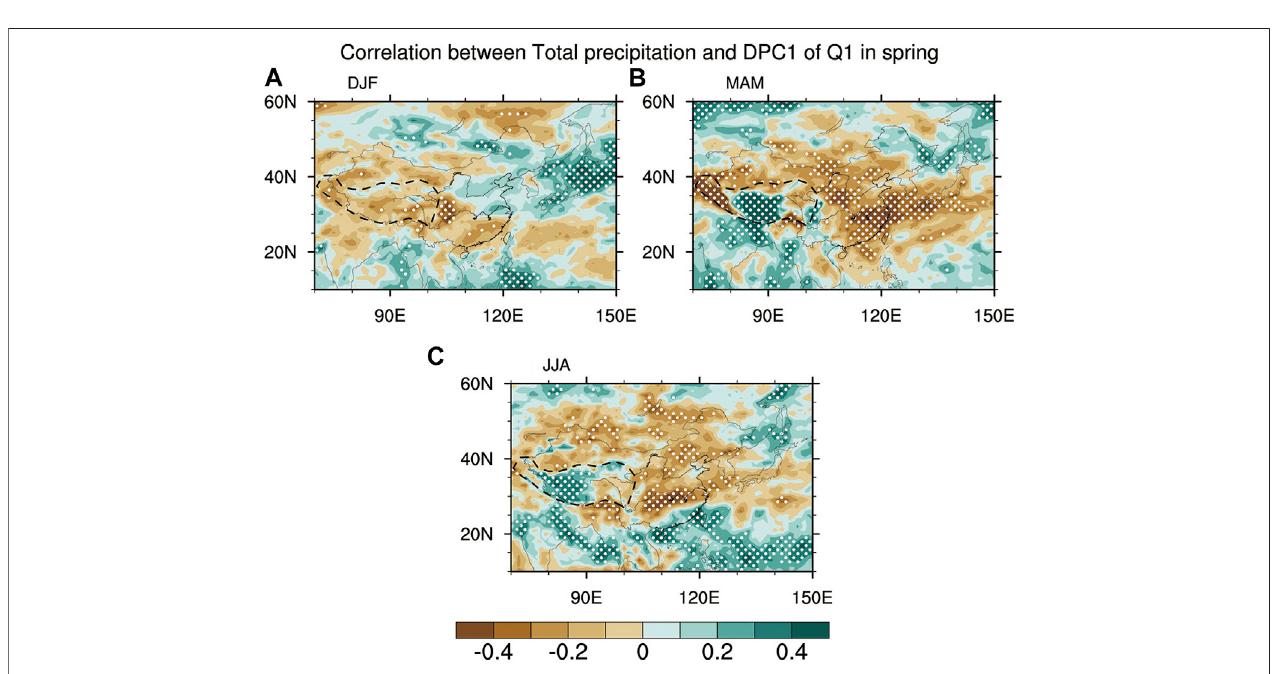
FIGURE 13 | Distribution of the correlation coef fi cients between DPC1 and precipitation in the time period 1979 – 2020 in (A) previous winter, (B) spring and (C) summer. White dots indicate statistical signi fi cance at the 90% con fi dence level.